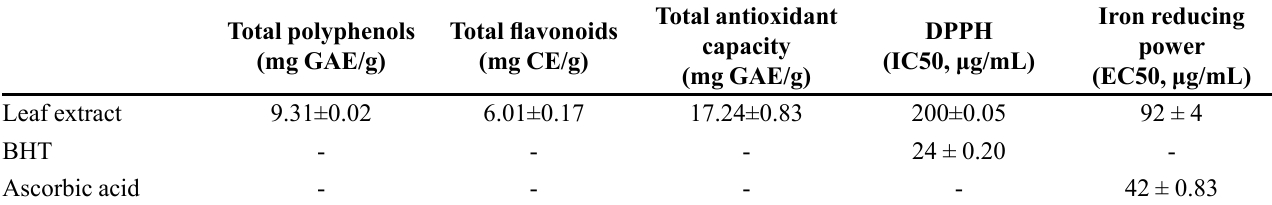
TABLE I - Total polyphenol, flavonoid contents and antioxidant capacity of Lycium europaeum extract